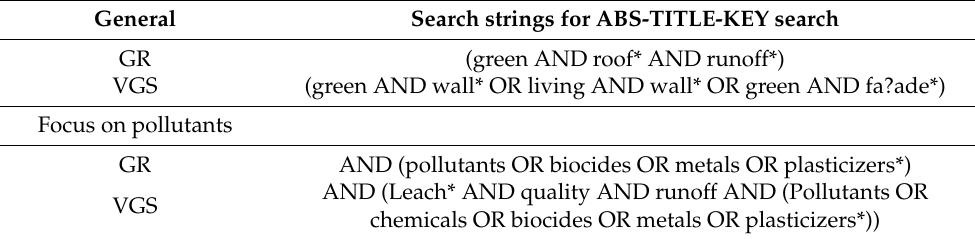
Table 1. ABS-TITLE-KEY search for green roofs and vertical greenery systems. General Search strings for ABS-TITLE-KEY search GR (green AND roof* AND runoff*) VGS Focus on pollutants GR AND (Leach* AND quality AND runoff AND (Pollutants